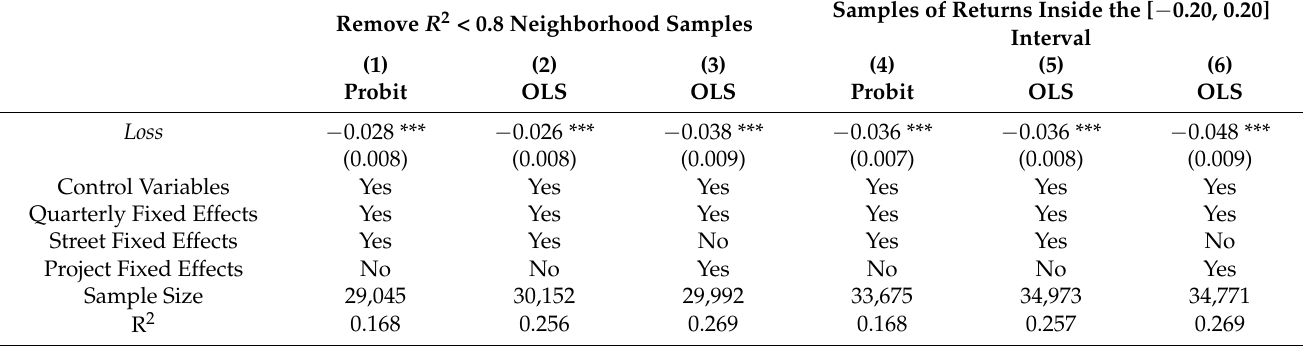
Table 7. Robustness analysis: remove samples of unreliable and extreme